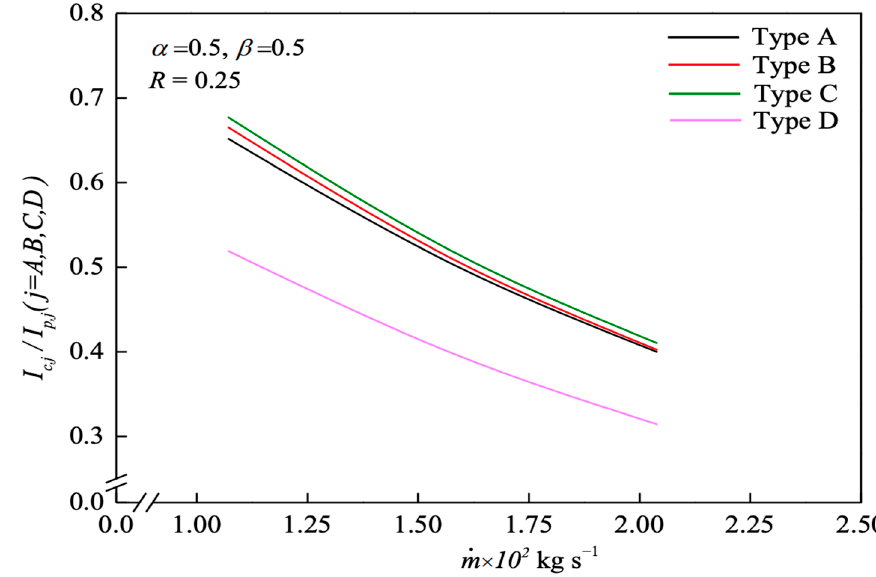
Figure 12. The ratio of the collector efficiency improvement and hydraulic dissipated power con- sumption increment.